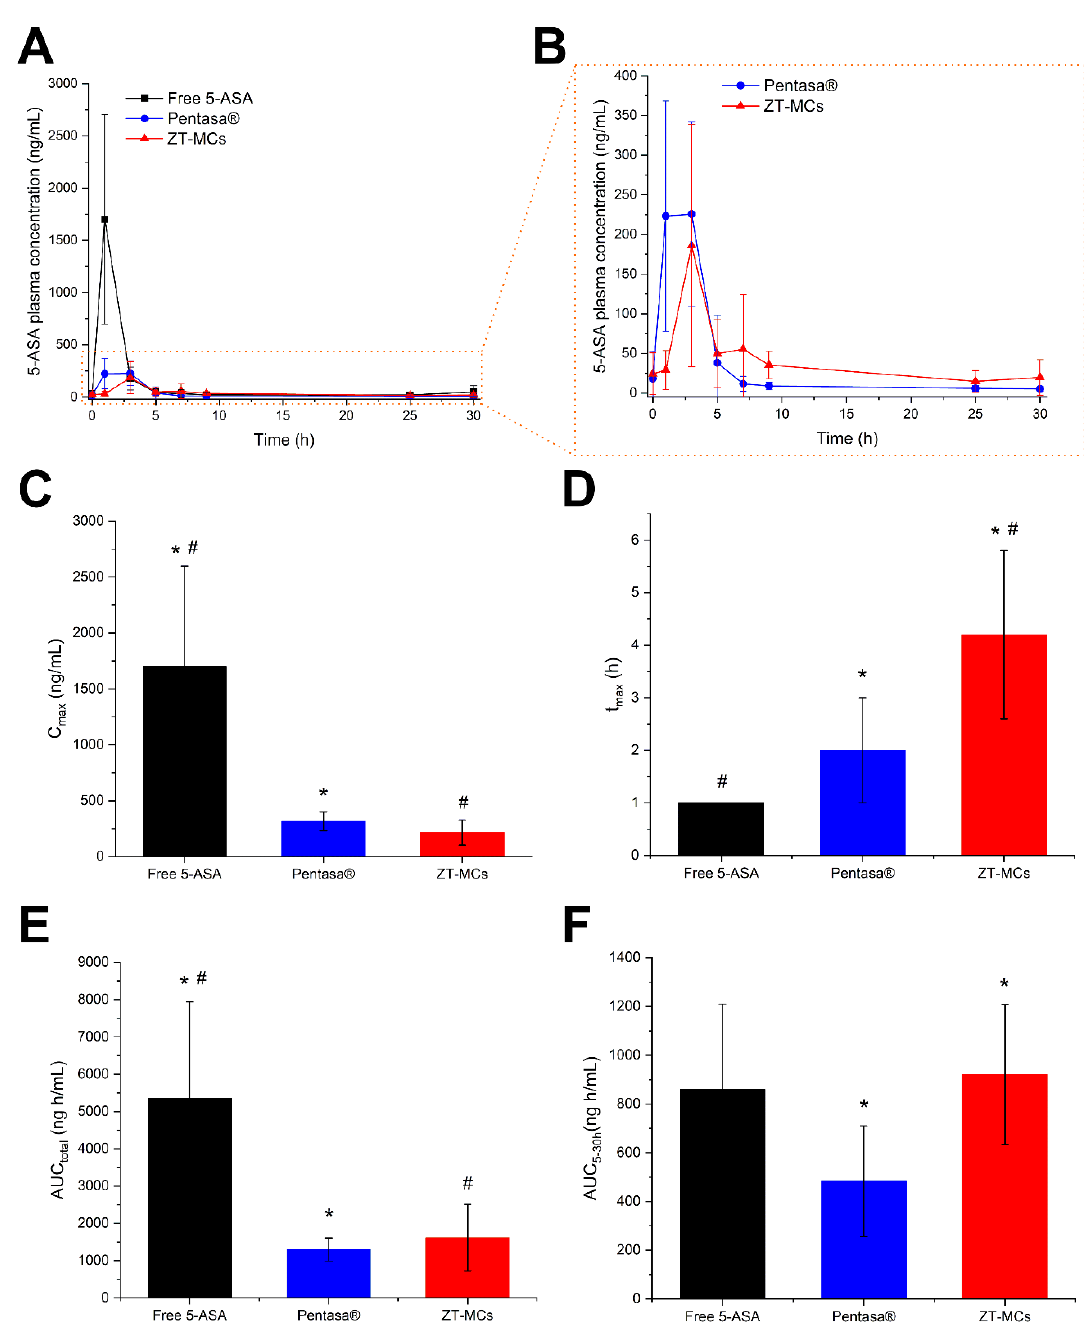
Figure 6. ( A ) 5-ASA plasma concentration over 30 h in rats dosed with either free 5-ASA, Pentasa ® , or ZT-MCs filled in gelatin capsules. ( B ) Zoom in on the Pentasa ® and ZT-MCs profiles. Non-compartmental pharmacokinetic parameters of 5-ASA, following oral administration to rats, including ( C ) Cmax, ( D ) tmax, ( E ) AUCtotal, and ( F ) AUC5-30 h. Data are presented as mean ± SE, n = 5,6. *, # represent a statistically significant difference ( p ≤ 0.05).